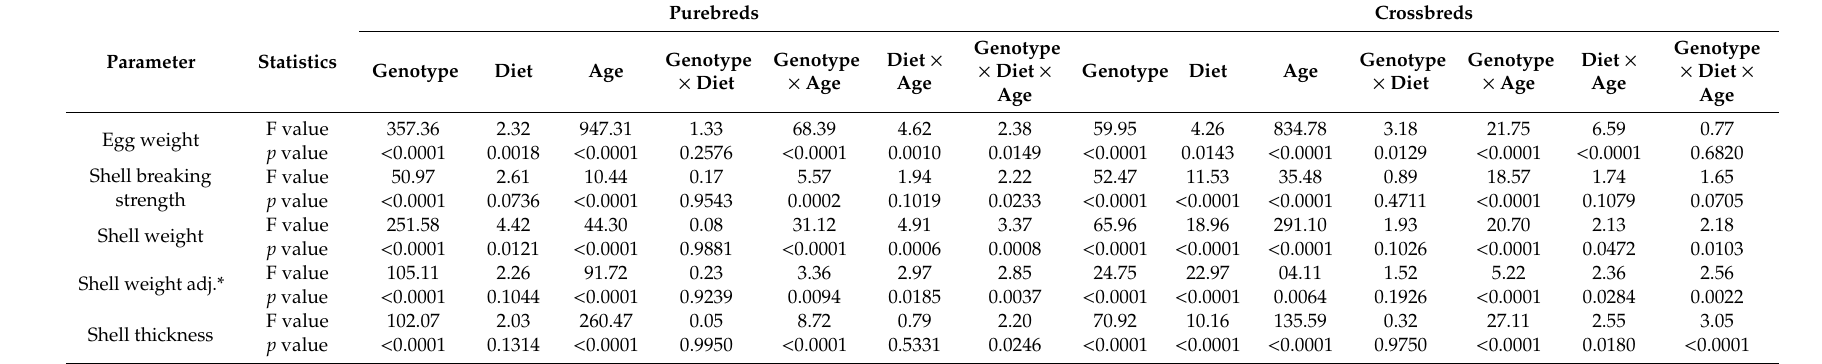
Table 2. E ff ect of genotype, diet, age and their interactions on di ff erent egg quality